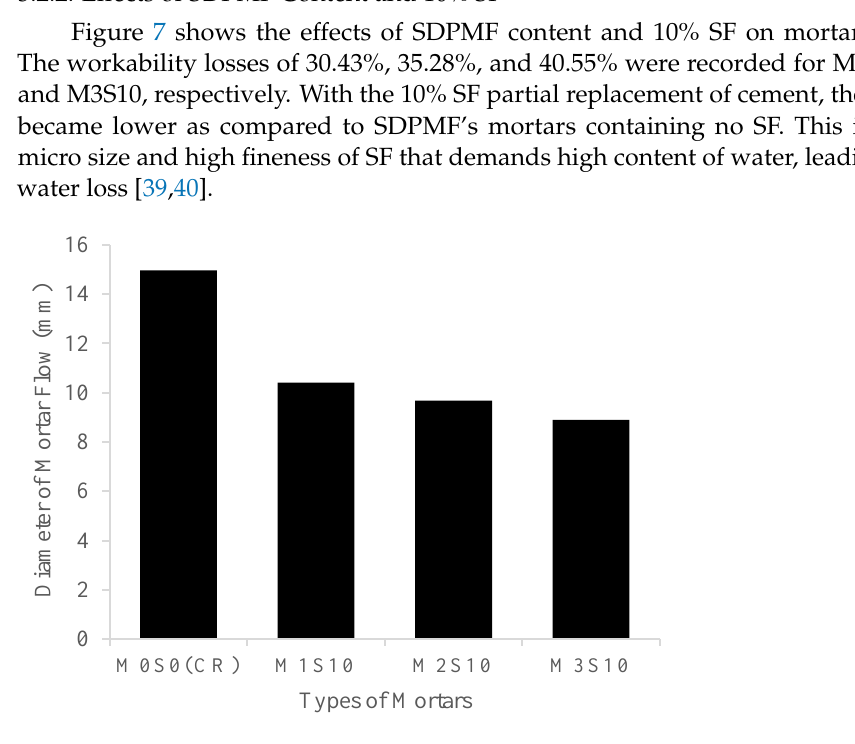
Figure 8. Effects of SF content on the workability of mortars containing 1% SDPMFs. 3.3. Water Absorption and Open Porosity Table 4 shows the results of water absorption, open porosity, and apparent density of all mixtures except for M0S20 which is not included in these tests. The standard devia- tions for all tests are also presented. With respect to water absorption, it can be seen that the mortars containing SDMPF fibers showed higher absorption than the control one. Sim- ilarly, the open porosity of the mortars containing SDPMFs is higher than the control one. Even though the content of SDPMFs increases from 1% to 3% in the mortars. However,